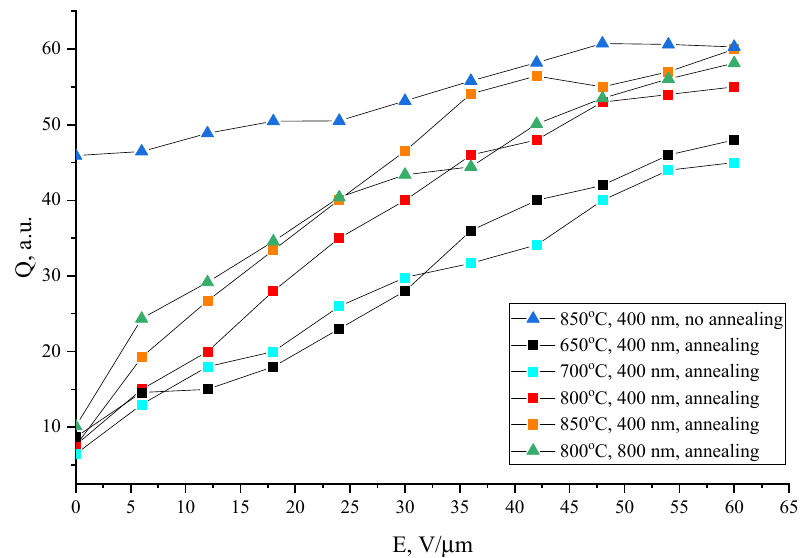
Figure 6. Dependencies of the Q-factor of the BTS based planar capacitors on control electric field strength.